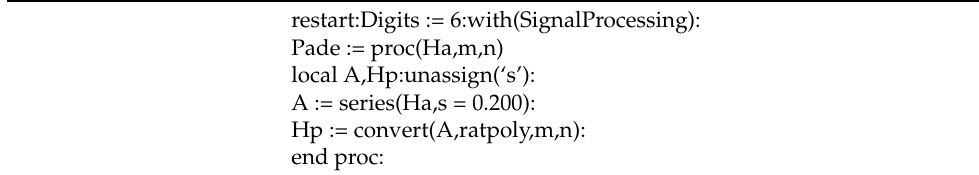
Table 15. Maple 18 code of Pade’s